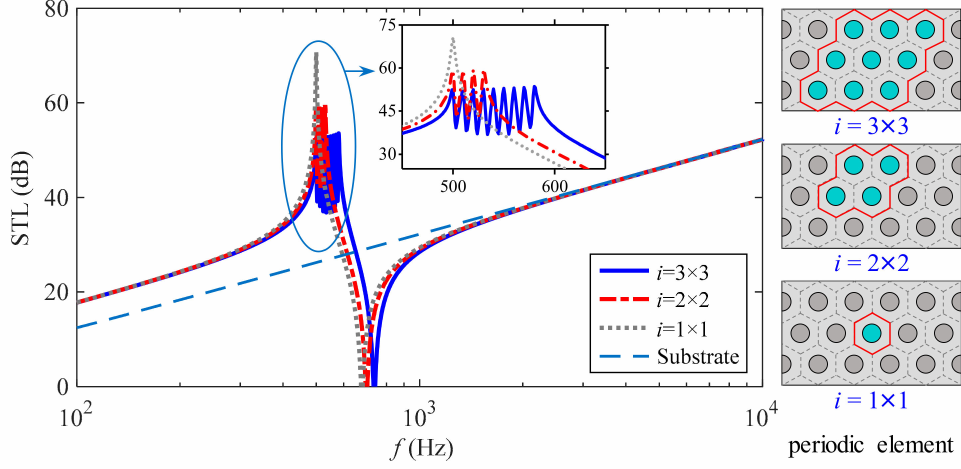
Figure 10. High-performance broadband sound insulation of the present